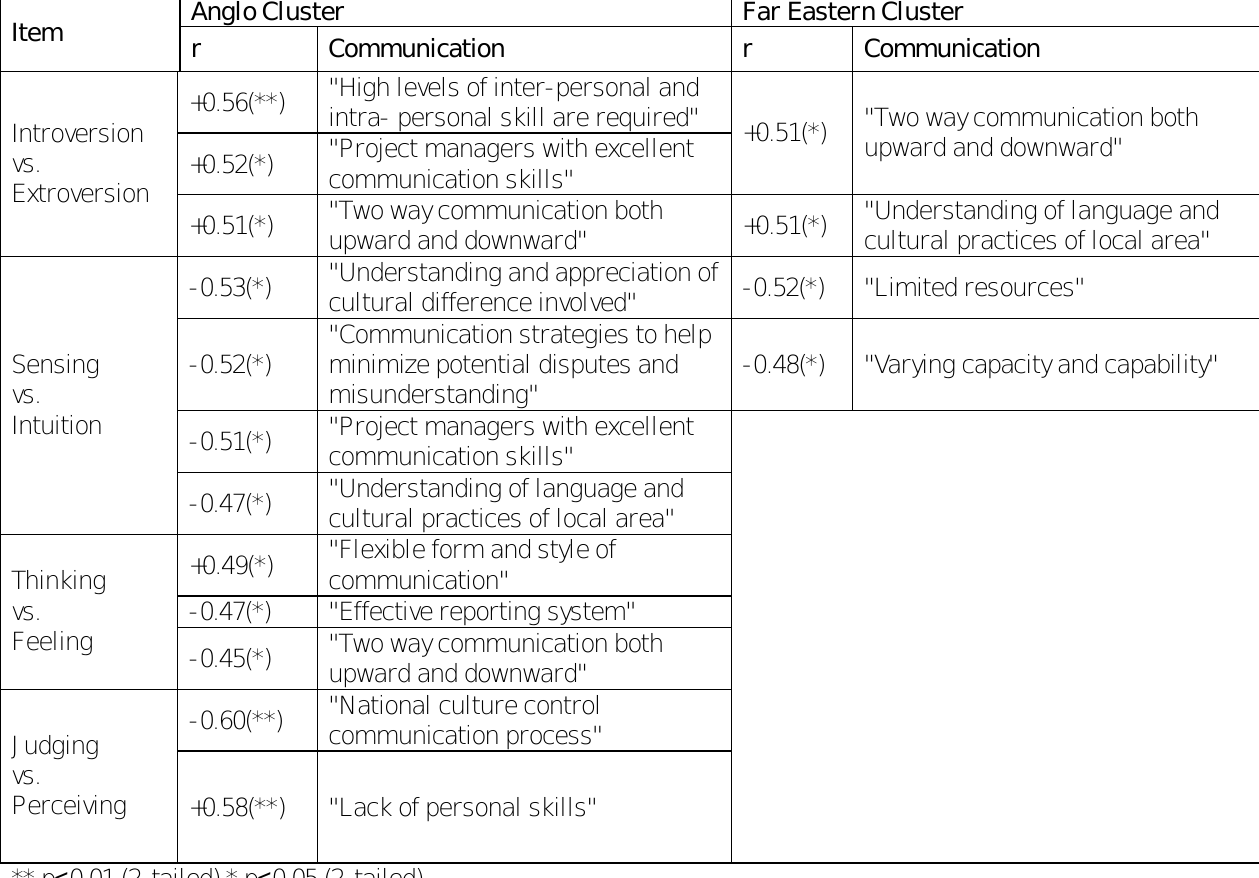
Table 7: Correlation between Personal Dimensions and Communication Variables Anglo Cluster Far Eastern Cluster